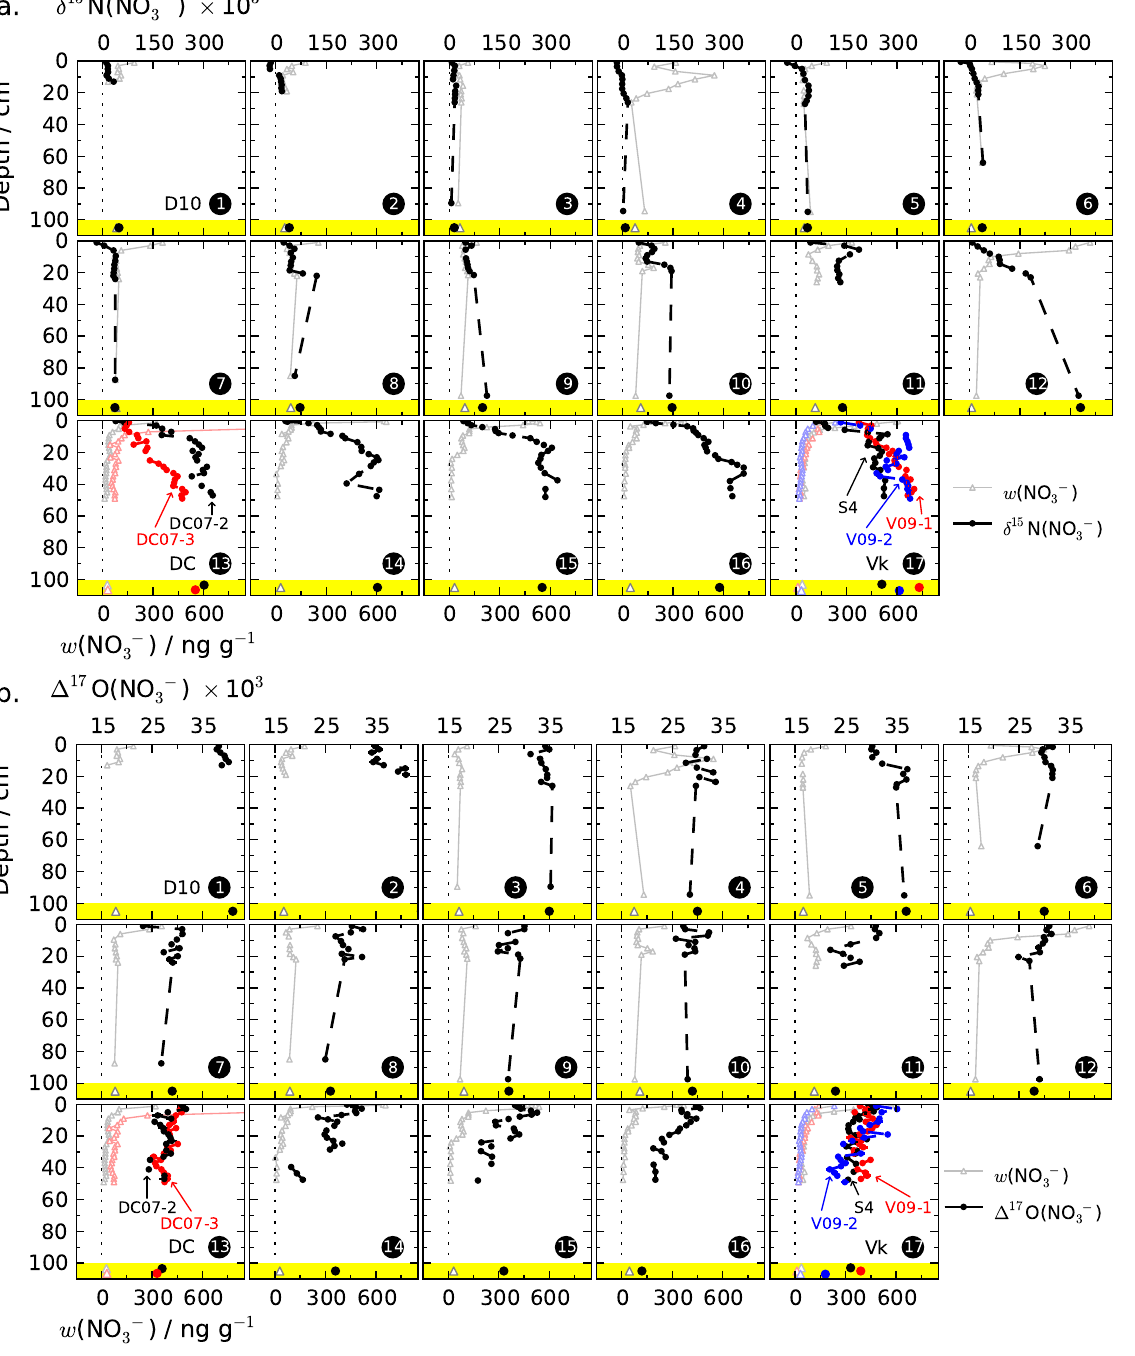
Fig. 2. Nitrate mass fraction and (a) δ 15 N and (b) 1 17 O profiles in the upper snowpack in East Antarctica. The numbers refer to the individual locations identified in Fig. 1 and Table 1. For the Dome C and Vostok sites, the colours refer to the different snow pits sampled in those locations: DC07-2 in black and DC07-3 in red, S4 in black, V09-1 in red and V09-2 in blue, respectively. The triangles and circles in the yellow shaded area below 1m in each panel represent the asymptotic nitrate mass fraction ( w (as.)) and δ 15 N ( δ 15 N(as.)) and 1 17 O ( 1 17 O(as.)) calculated for each